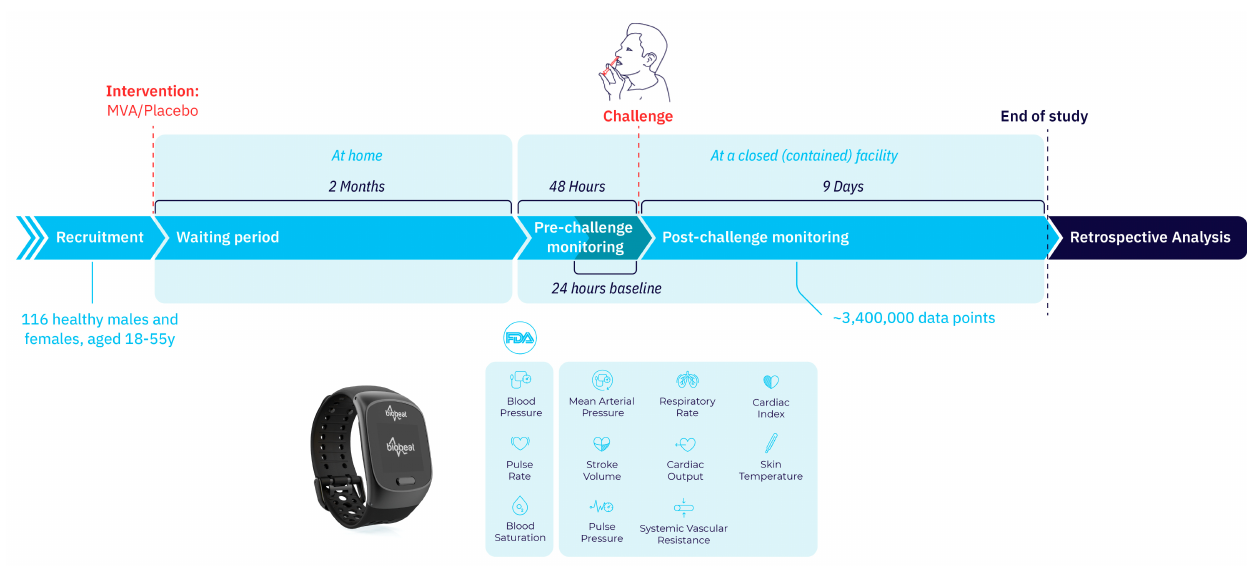
Figure 1. The CONSORT diagram with participants’ flow.